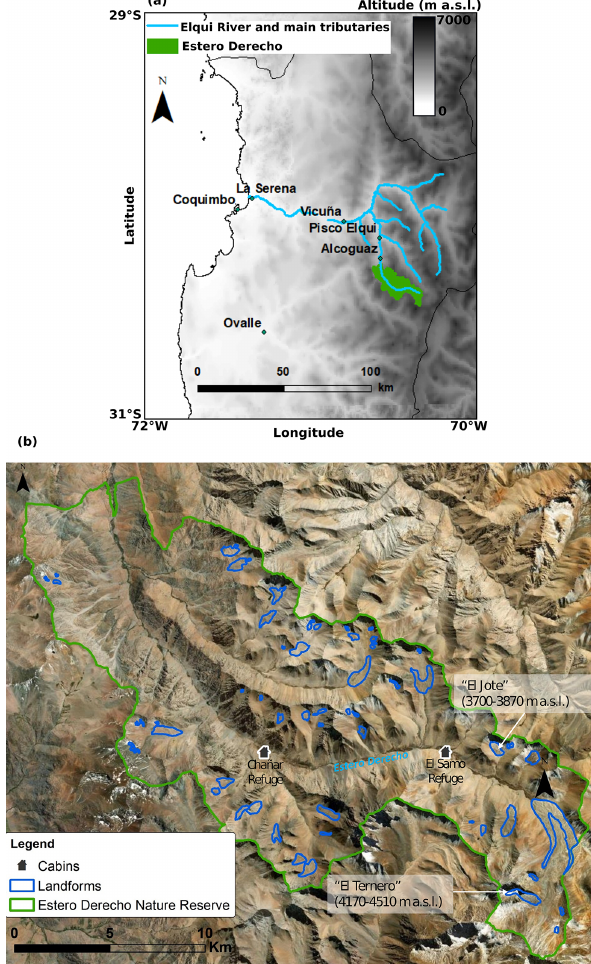
Figure 1. (a) Overview map indicating the location of Estero Dere- cho ( ∼ 30 ◦ S, 70 ◦ W) in the Coquimbo Region of Chile. Elevation map from the Advanced Spaceborne Thermal Emission and Reflec- tion Radiometer Global Digital Elevation Model (ASTER GDEM). (b) Detailed map of Estero Derecho with an inventory of land- forms created by the Centro de Estudios Avanzados en Zonas Áridas (CEAZA). The delineations for El Jote and El Ternero were created specifically for this study from the Esri base map satellite imagery. Both landforms are labelled with their respective elevation